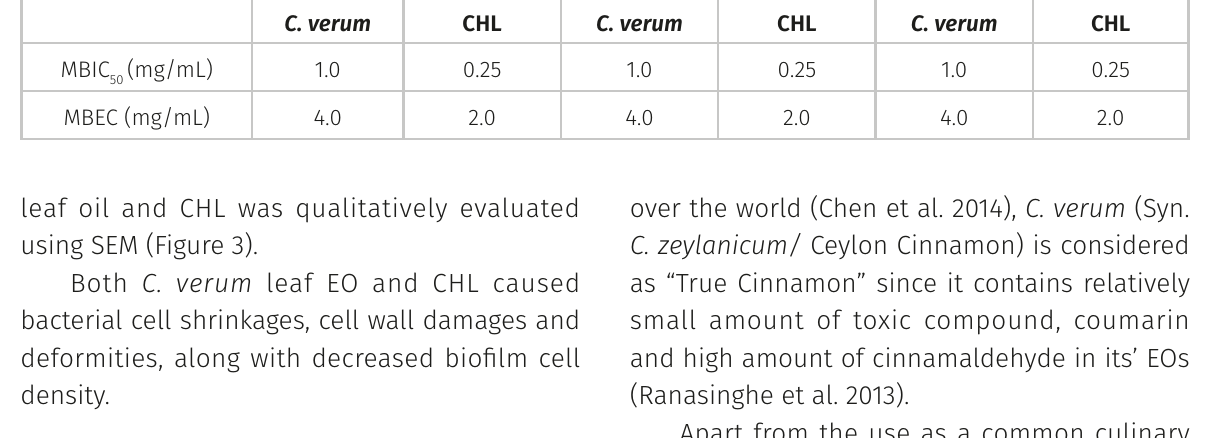
) and Minimum Biofilm Eradication Concentration 50